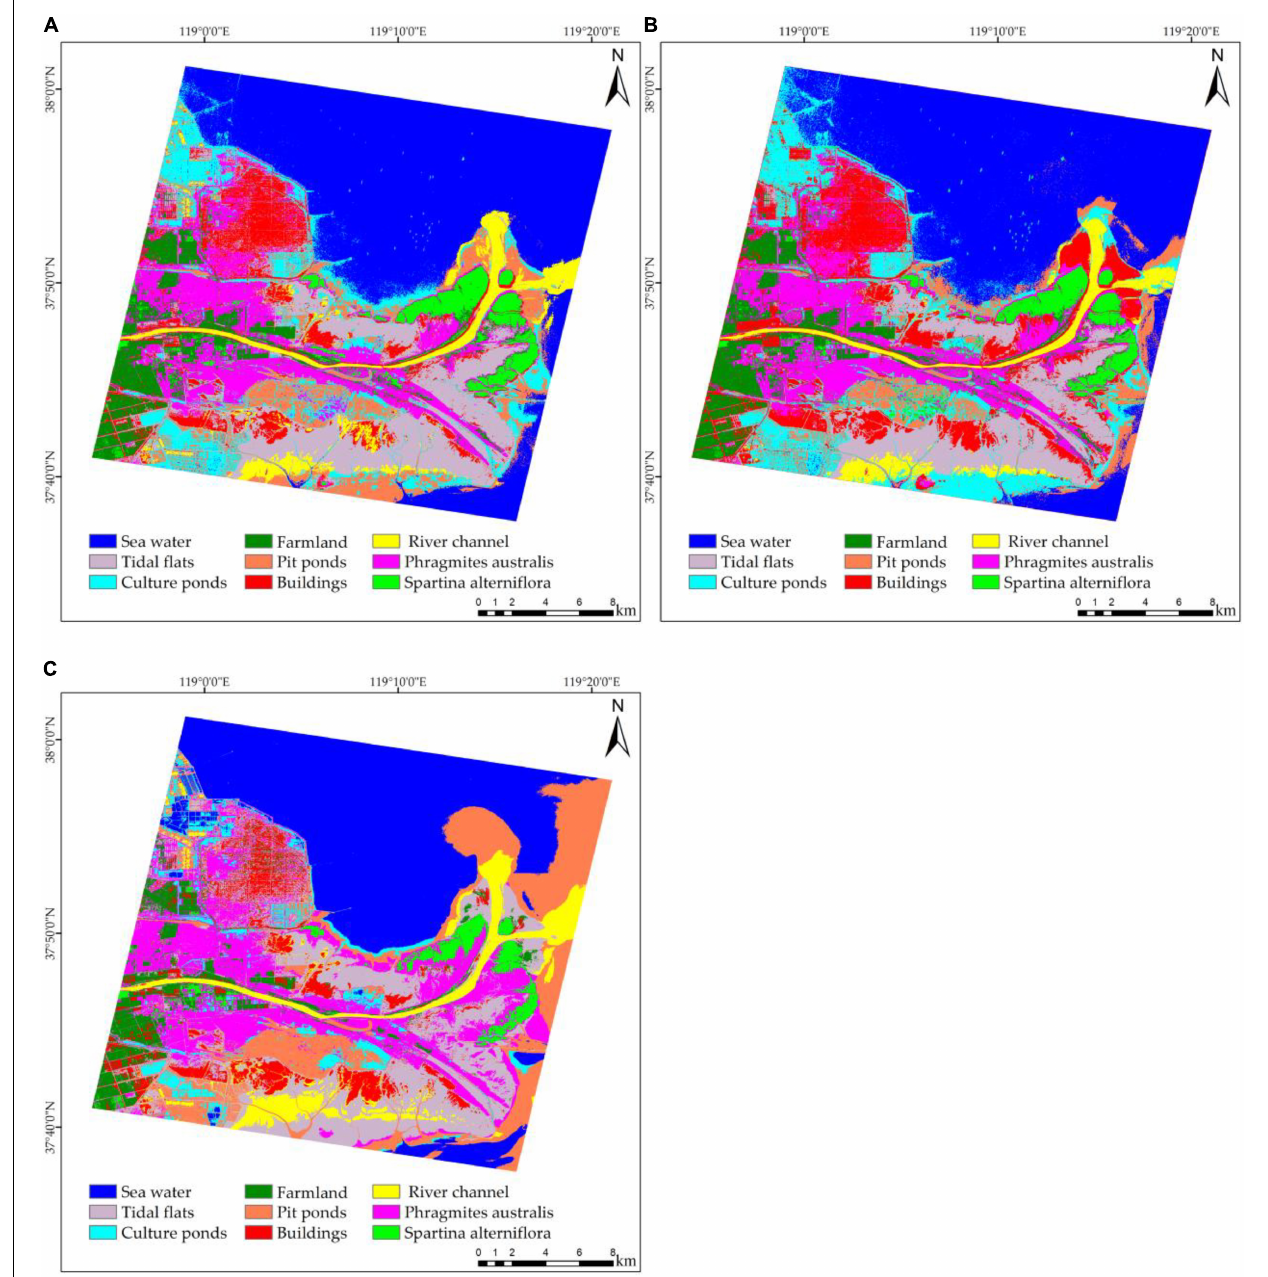
FIGURE 9 | Results of different classification methods based on joint features using November 2018 data: (A) Support vector machine classification; (B) Maximum likelihood classification; and (C) Minimum distance classification.